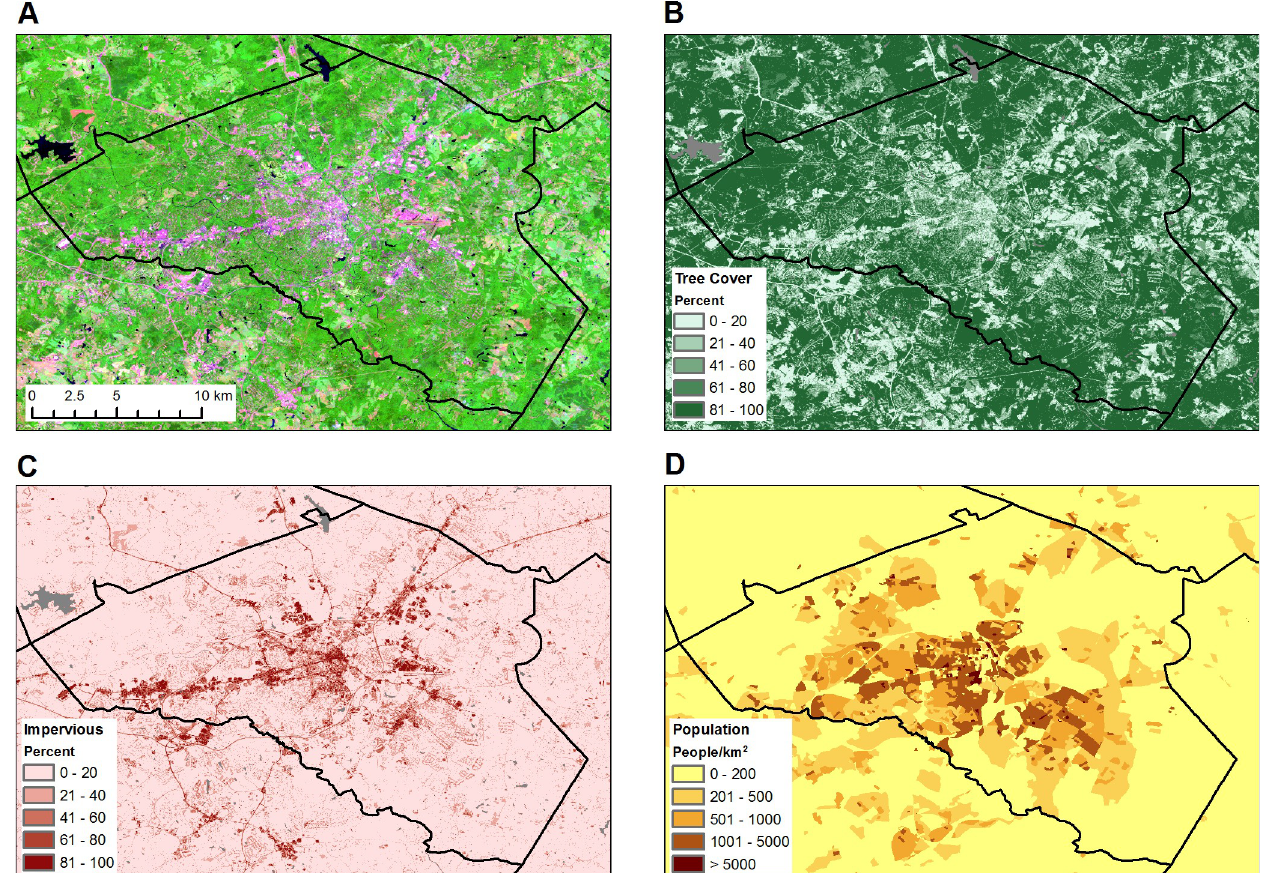
Fig 1. Maps of the Athens-Clarke County, GA study area. A) False-color Sentinel-2 image from 2017 with the shortwave infrared band displayed as red, the near infrared band displayed as green, and the green band displayed as blue. With this band combination, tree-covered areas are green and impervious surfaces are pink and red.; B) Tree cover map from Sentinel-2 imagery with water bodies displayed as gray; C) Impervious surface map from Sentinel-2 imagery with water bodies displayed as gray; D) Block-level population density map from the 2010 U.S. Census. Solid black lines represent county boundaries. The maps were produced using ArcGIS version